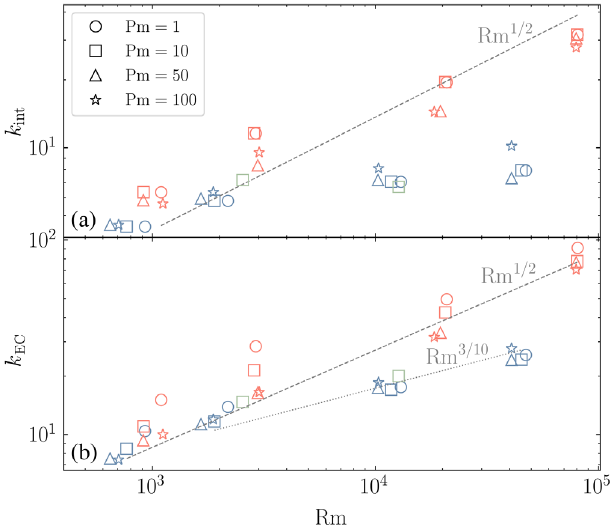
FIG. 10. Dependence of (a) the integral scale k [Eq. (21)] and int (b) the energy-containing scale k [Eq. (22)] on Rm at the end EC of the kinematic stage (red markers) and in saturation (blue markers). Different markers correspond to different Pm, as indicated; the green squares refer to the saturated state of runs b2 ⋄ and c2 ⋄ . At the end of the kinematic stage, both k and k int EC k ∼ k ∼ l − 1 vary approximately as Rm 1 = 2 , consistent with k u η . In int EC saturation, k appears to approach a constant value at large Rm, int at least for Pm ≤ 50 , while k becomes consistent with the EC tearing scale ∝ Rm 3 = 10